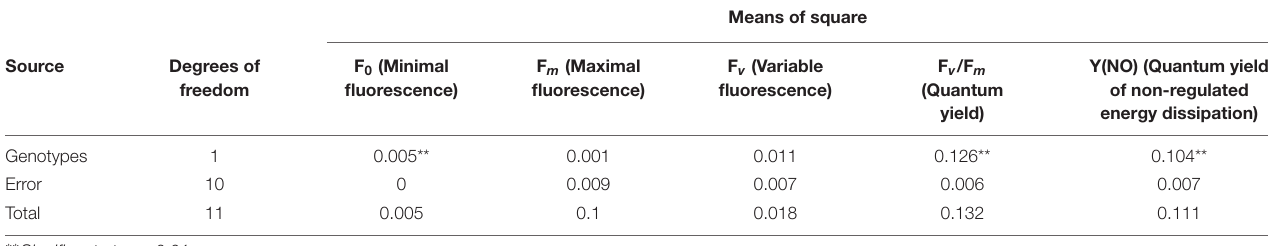
TABLE 10 | Analysis of variance of fluorescence parameters between heat-tolerant (UPU85-86) and heat-sensitive genotypes (PKGU-1).